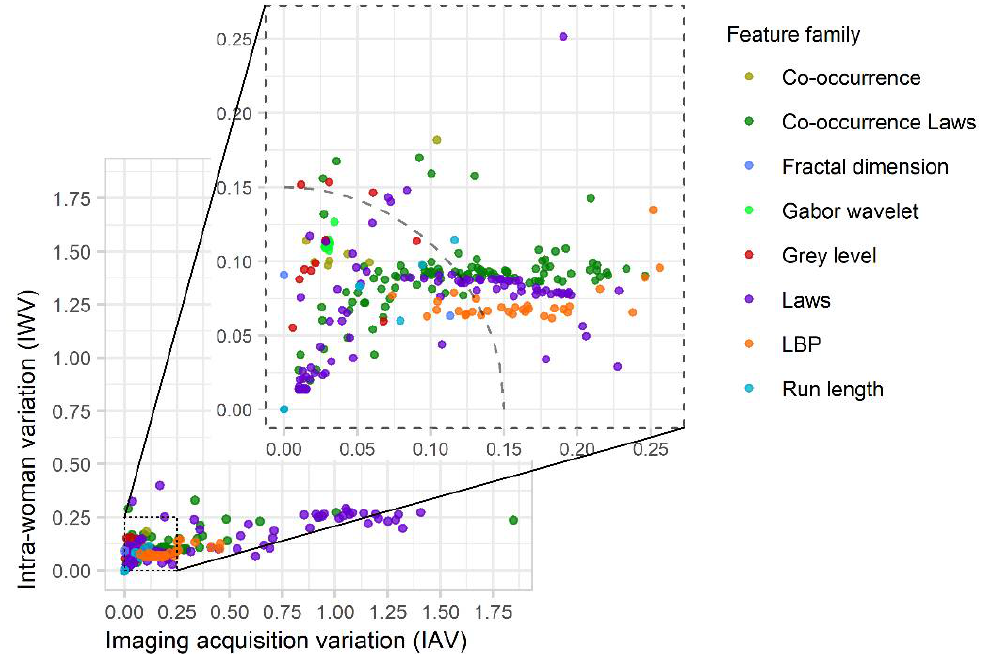
Figure 4. Summary of results obtained in IAV × IWV space for 341 features. The circular arc illustrates a threshold (CMV = 0.15) used to identify robust features (158 of 341 features, or 46%, are within this cutoff).